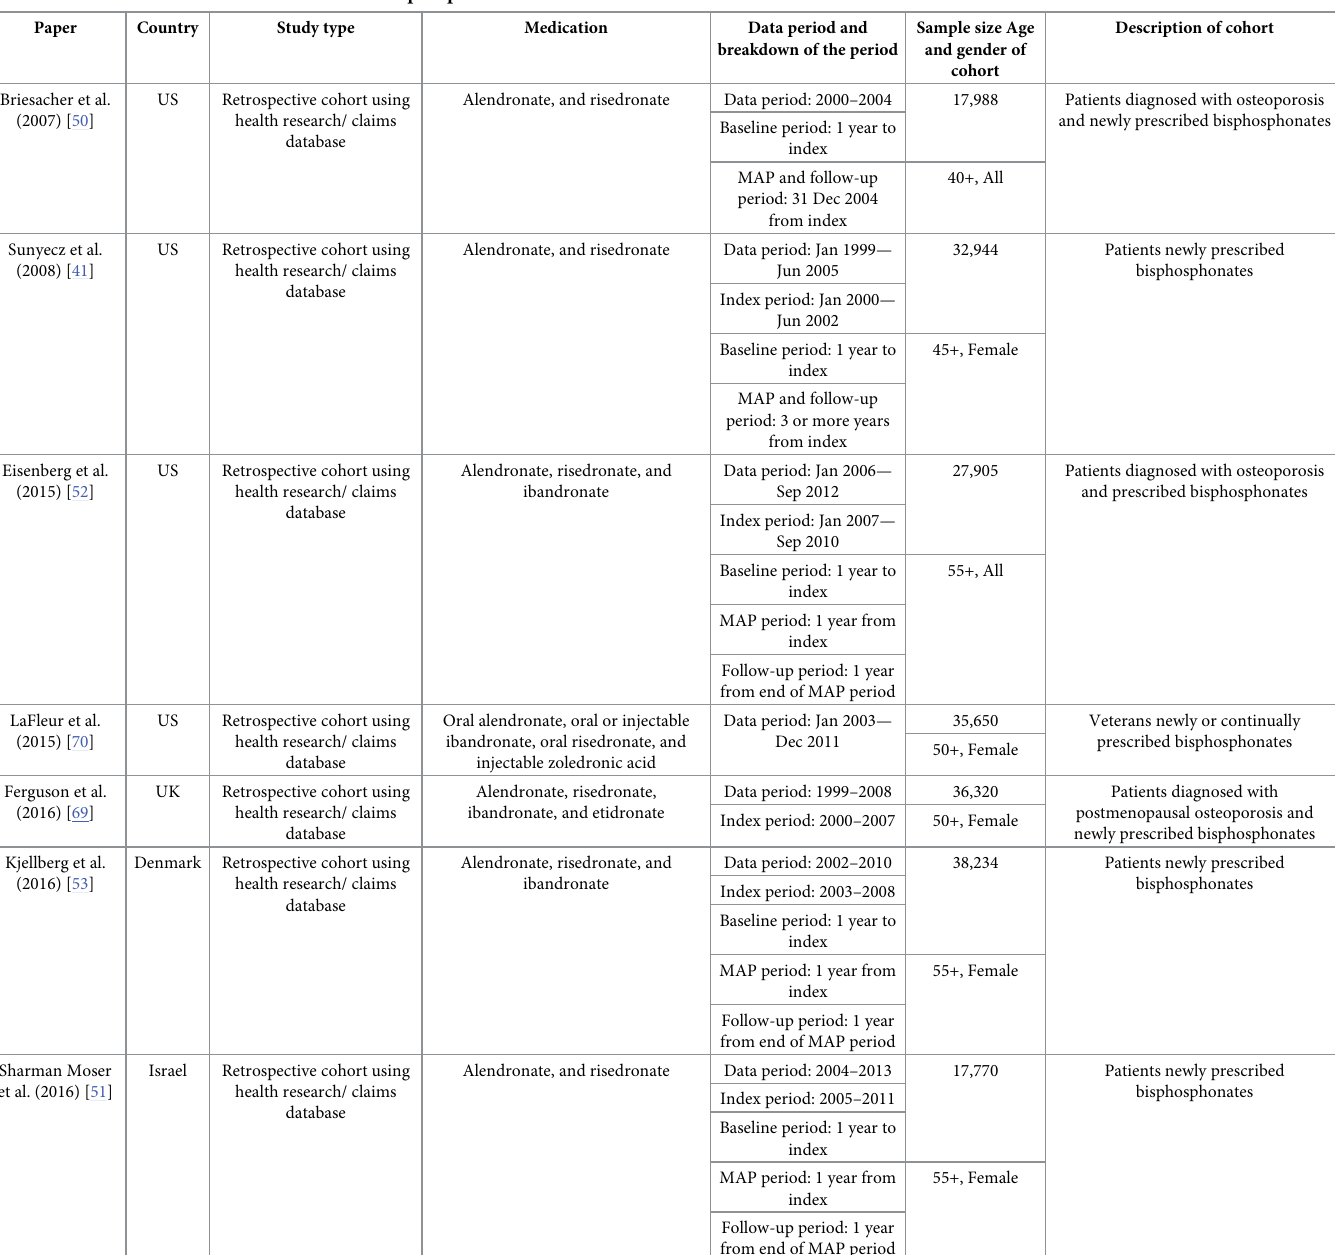
Table 4. Characteristics of reviewed studies on